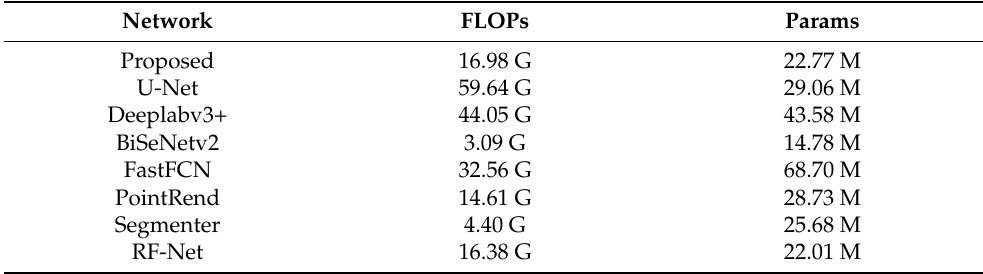
Table 6. Computational complexities of different methods for comparative